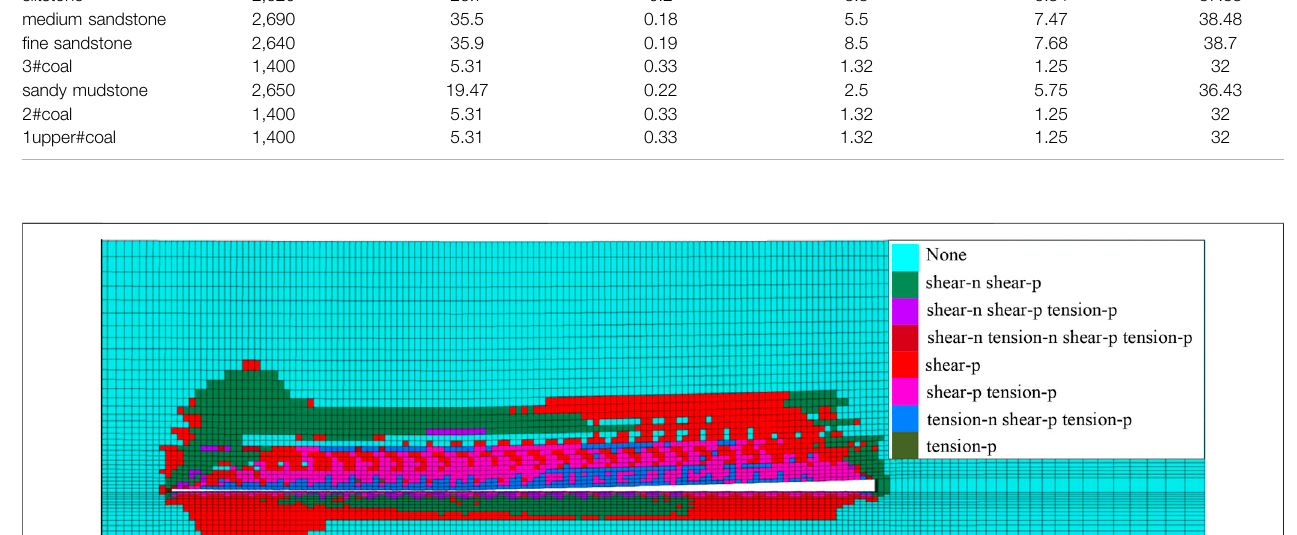
Frontiers in Earth Science |